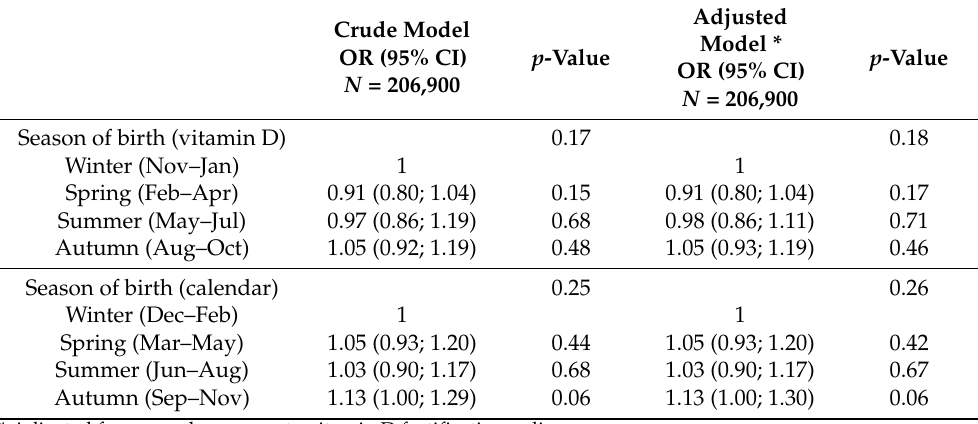
Table 3. Odds for incident IBD according to season of birth, logistic regression with both crude and adjusted models.